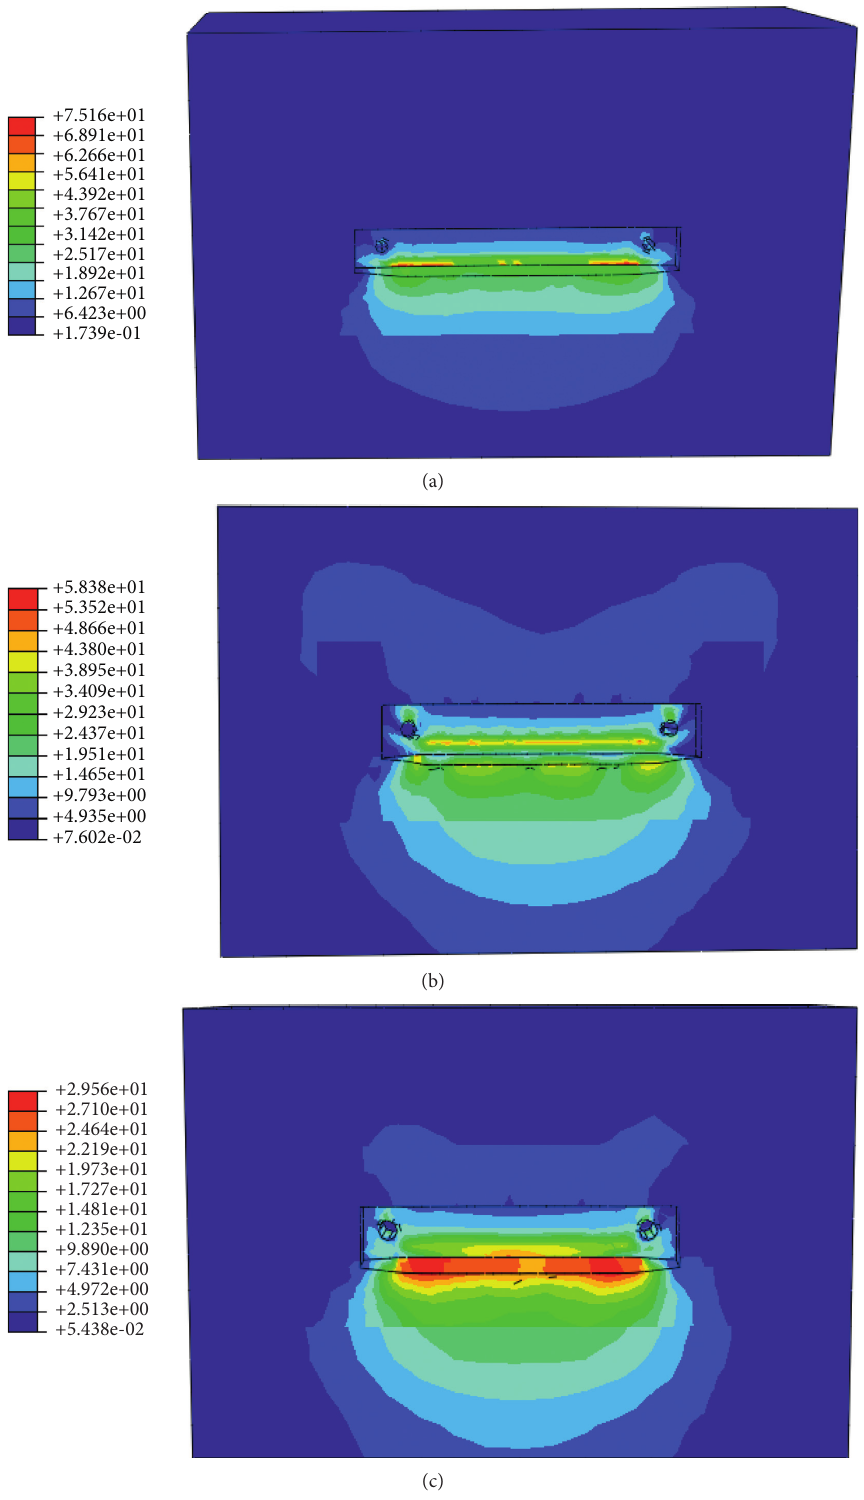
Figure 8: Concrete stress cloud diagram. (a) B-1, (b) B-2, and (c) B-3 (unit: